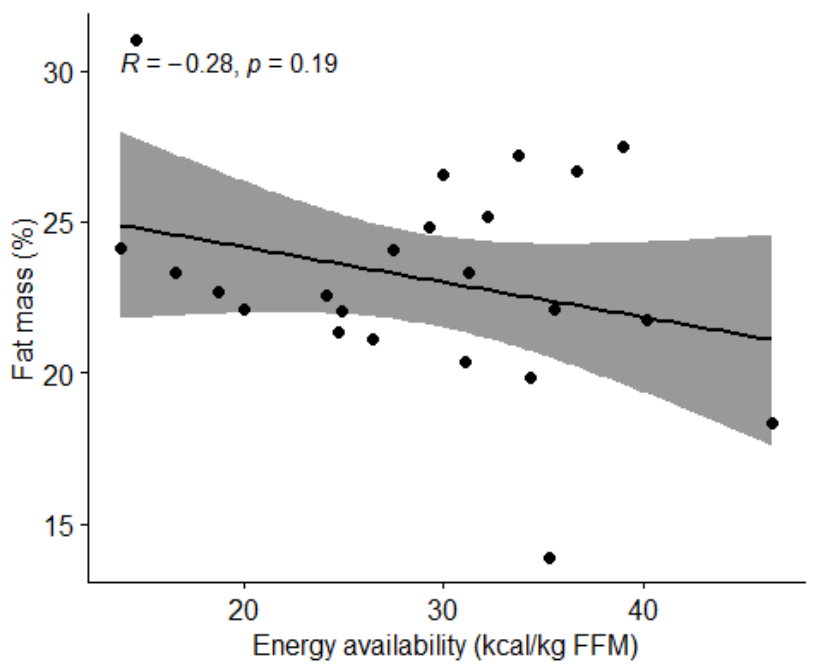
Figure 6. Correlation between energy availability and body fat percentage in football players. Dots represent individual participants ( n = 23). Grey shaded area indicates 95% confidence interval (CI).